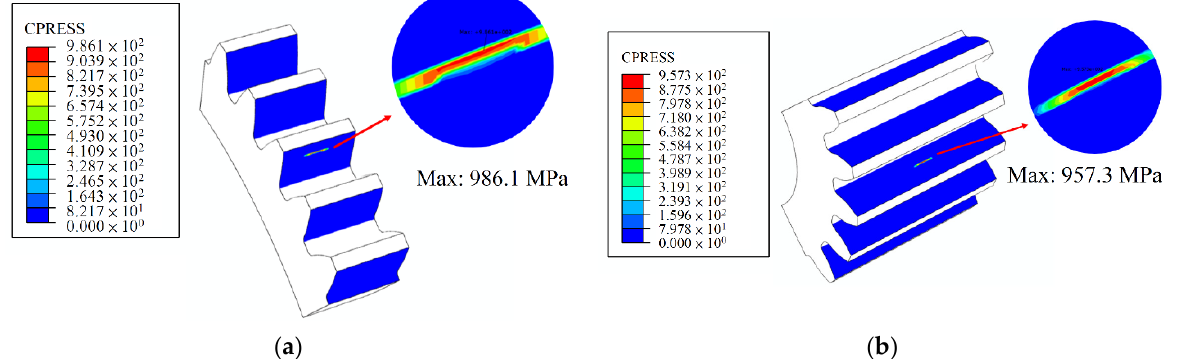
Figure 8. Contact stress of optimum design with horizontal axial misalignment of 0.06°: ( a ) gear; ( b ) pinion.